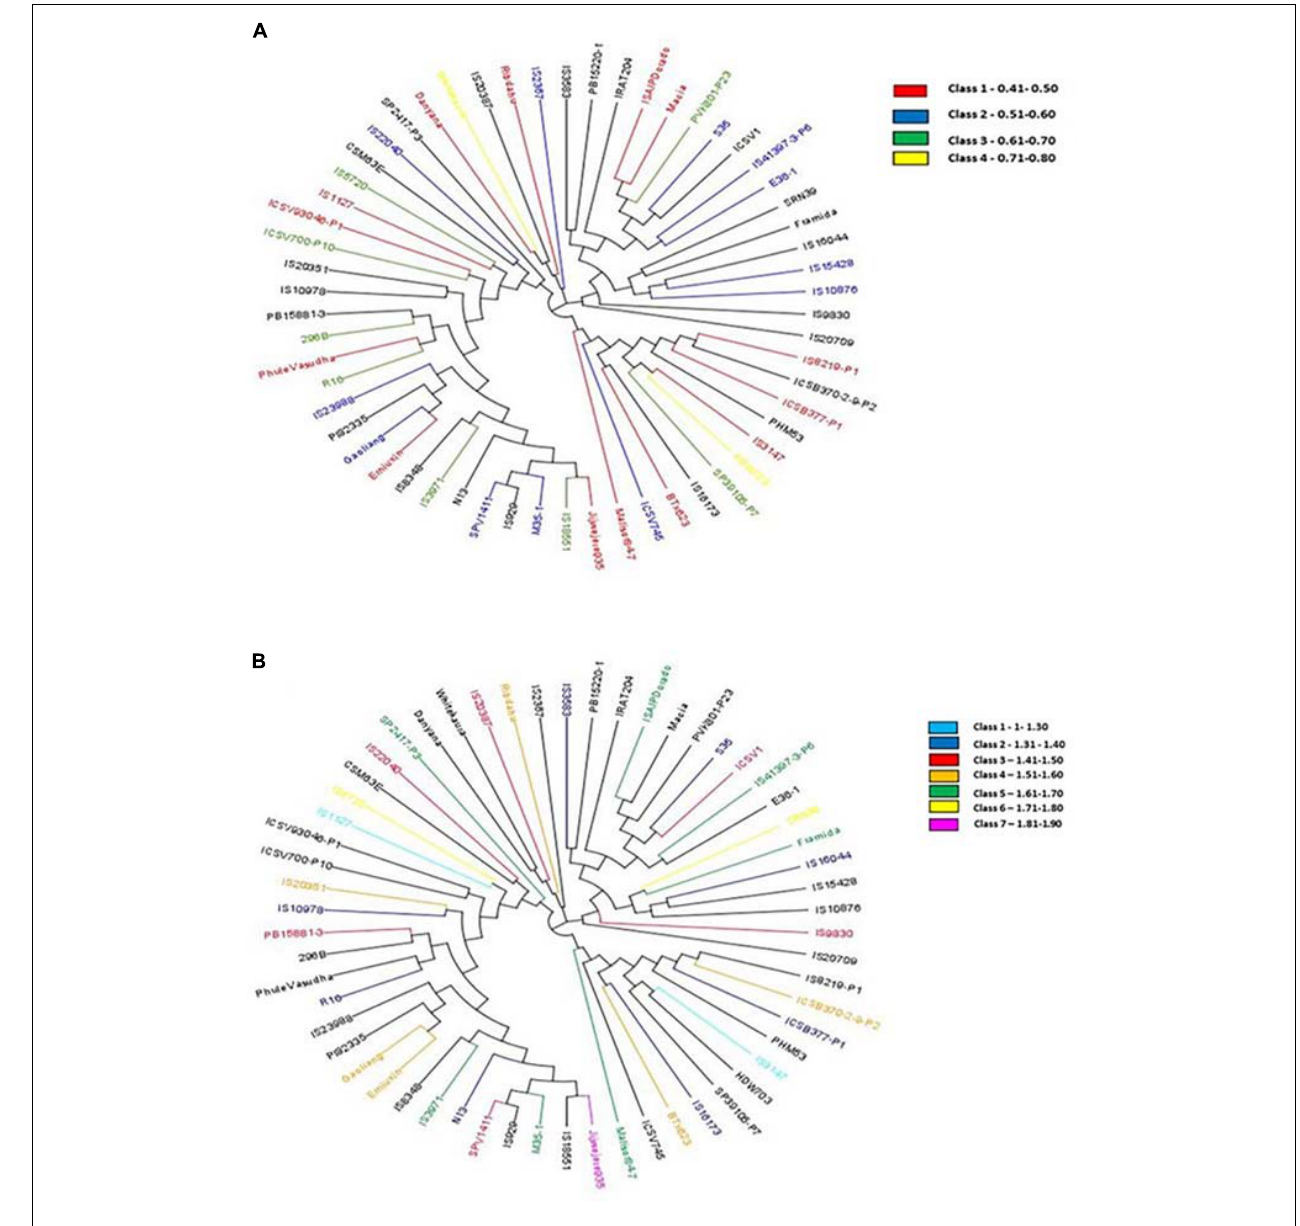
FIGURE 3 | (A) Phylogentic tree showing genotypes in different classes based on stalk N (SN%) content [from the range of low (0.41–0.50) to high (0.71–0.80)]. (B) Phylogentic tree showing genotypes in different classes based on grain N (GN%) content [from a range of low (1–1.30) to high